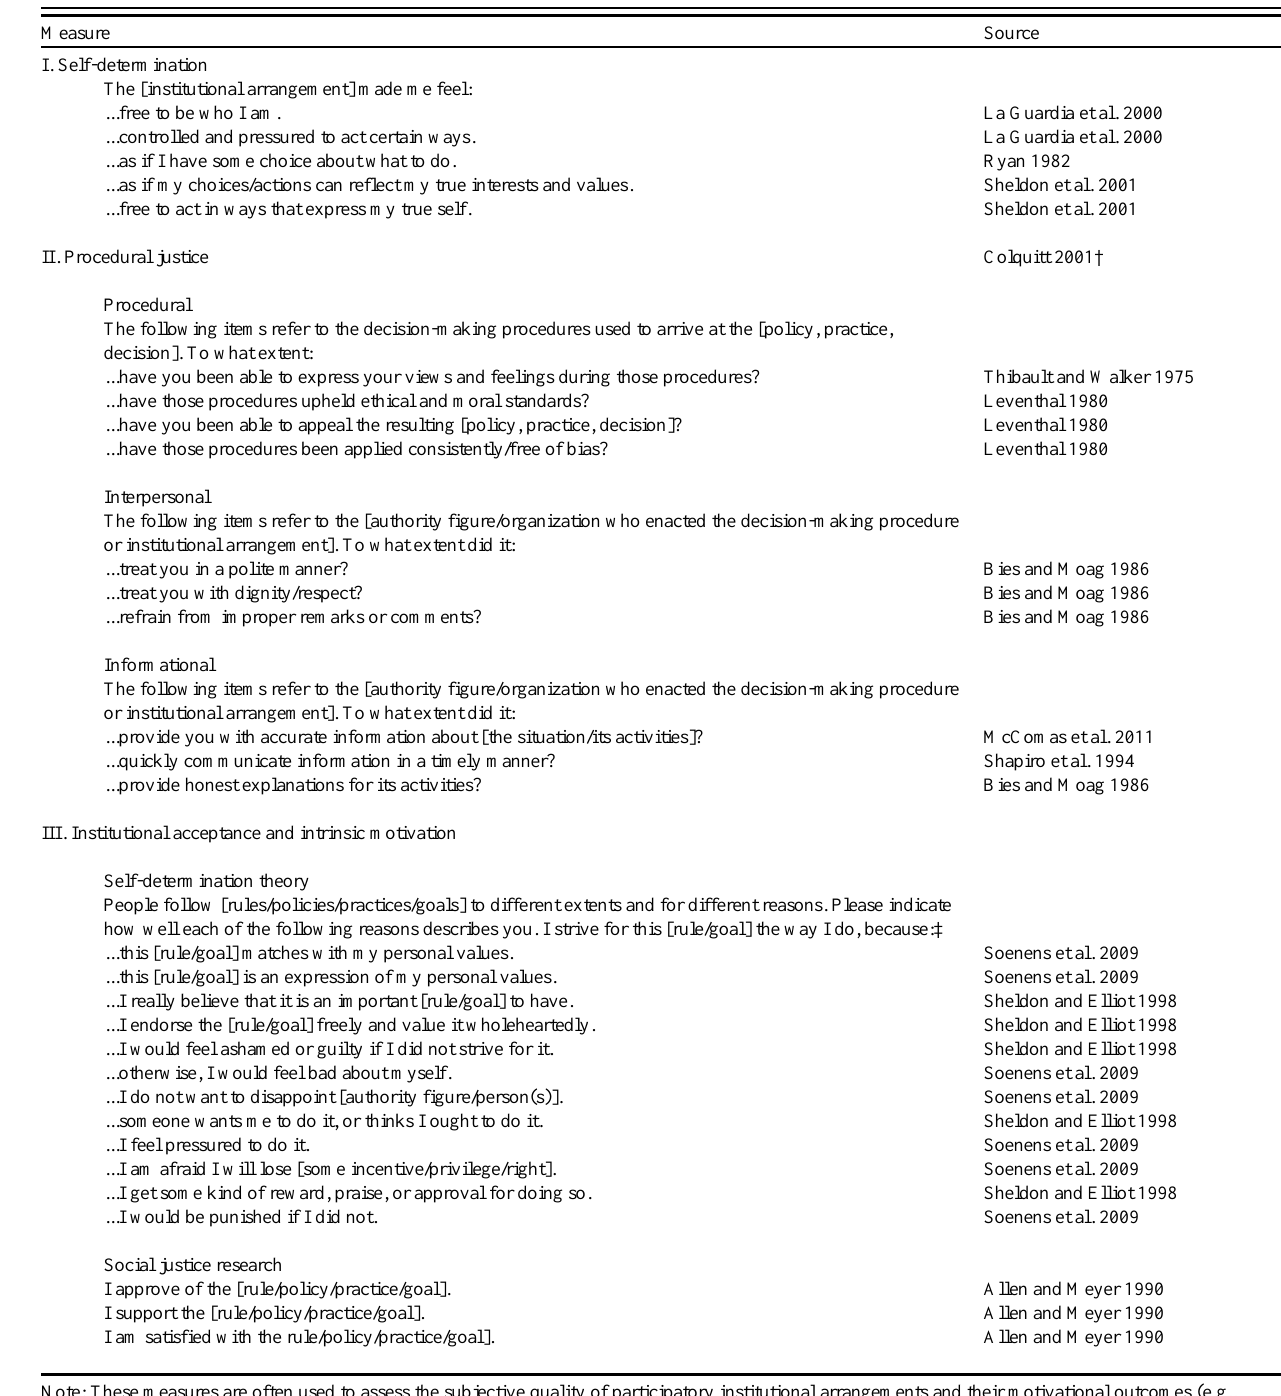
Table 1 . Sample psychological